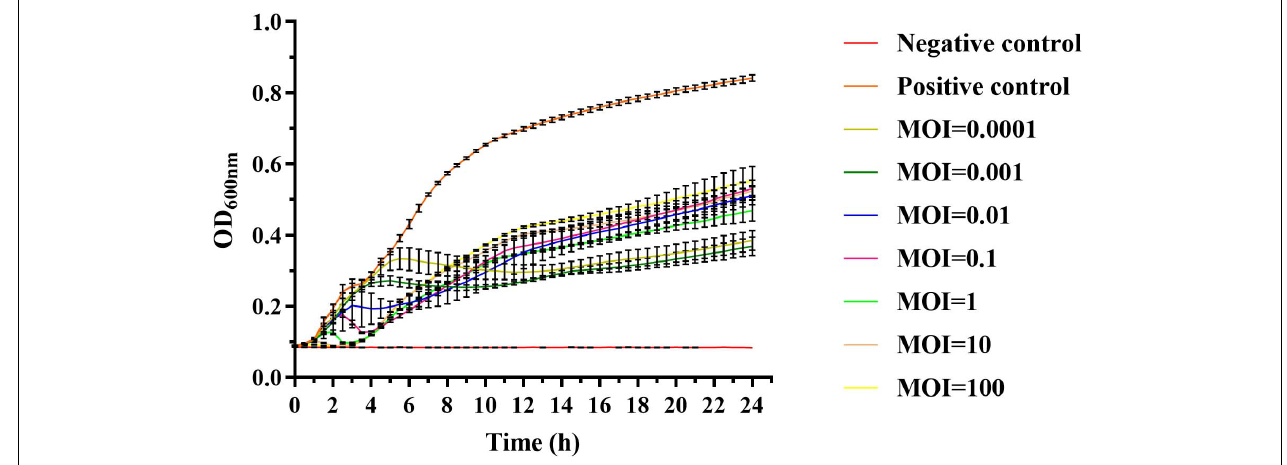
FIGURE 4 | In vitro lytic activity of phage vB_SalP_TR2 against S. Albany in Luria–Bertani (LB) medium with different MOIs (0.0001 to 100) at 37 ◦ C. OD 600 nm was measured at 30-min intervals. Non-phage-infected bacterial culture was the positive control, and LB medium was the negative control. Error bars indicate the standard